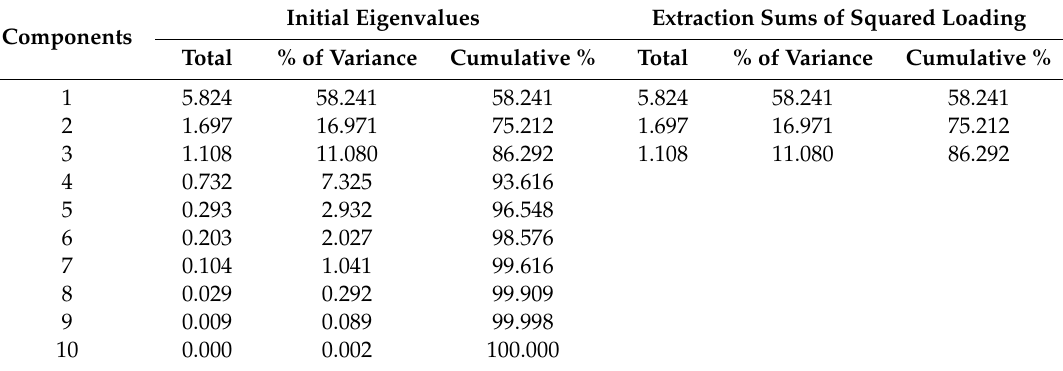
Table 2. Total variance explained.